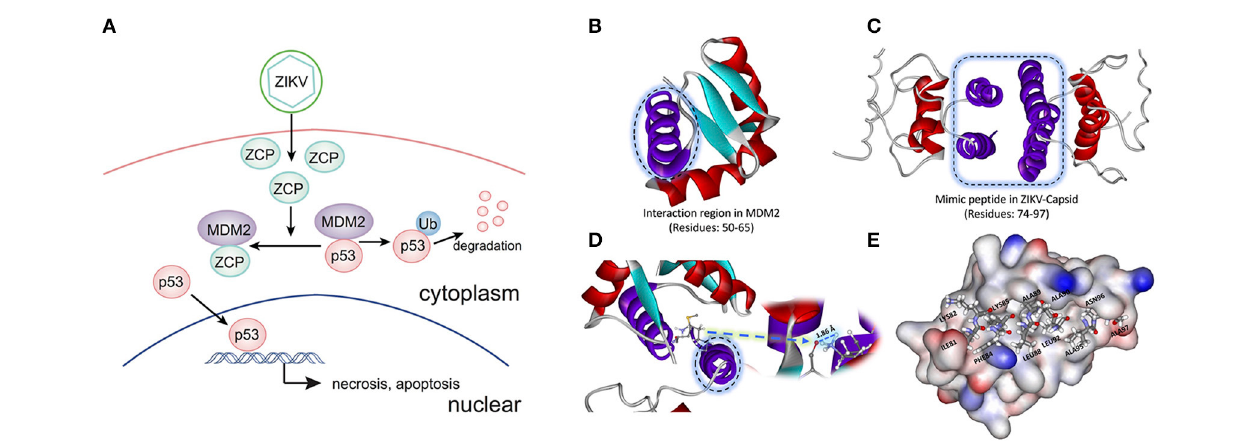
FIGURE 3 | Schematic diagram and structure of the interaction between the ZIKV capsid protein (ZCP) and MDM2. (A) Schematic diagram of the interaction between ZCP and MDM2 in the P53-mediated apoptosis pathways. (B) Binding domain (residues 50–65) in the MDM2 structure (PDB ID: 3W69) that is critical for the P53–MDM2 interaction is shown as a purple helix. (C) Homology modeling of ZCP, in which the C-terminal helix is colored purple (residues 74–97). (D) Strong hydrogen bonding is shown at the O of MET50 (ball-and-stick model) in MDM2, which binds to HZ2 of LYS85 (ball-and-stick model) in ZCP. Right purple helix is the mimic ZCP peptide (residues 74–97). (E) Match between residues 81–97 (ILE81, LYS82, PHE84, LYS85, LEU88, ALA89, ALA91, LEU92, ALA95, ASN96, and ALA97) in the C-terminal regions of ZCP and MDM2. MDM2 protein is shown in the protein surface style and the residues of the mimic peptide are shown with